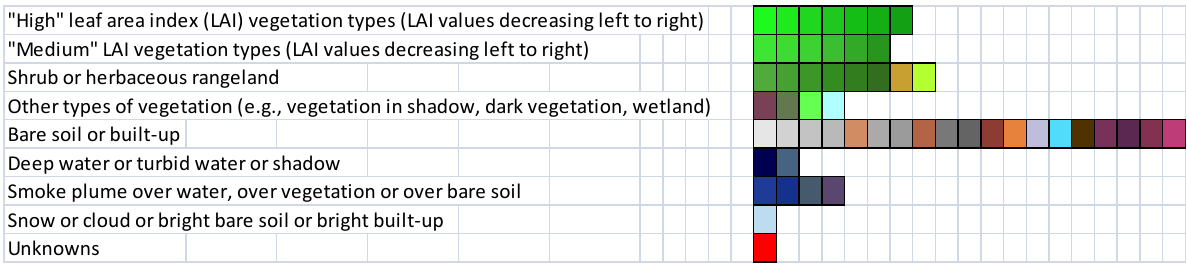
Table 3. Previously shown in [23]. Preliminary classification map legend adopted by Q-SIAM™ at fine semantic granularity consisting of 52 spectral categories (refer to Table 1). Pseudo-colors of the spectral categories are grouped on the basis of their spectral end member (e.g., ‘ bare soil or built-up ’) or parent spectral category (e.g., “high” leaf area index (LAI) vegetation types). The pseudo-color of a spectral category is chosen so as to mimic natural colors of pixels belonging to that spectral category. This legend gives a clue about the semantic “parent-child” relationship supported by Q-SIAM™ at different semantic granularity levels (refer to Figure 7 below). For example, a line-specific OR-combination of the 52 “child” spectral categories detected at the fine semantic granularity level across the 9 lines of Table 3 would provide 9 “parent” spectral categories at a coarser level of semantic granularity. Since it deals with symbolic reasoning, then this semantic aggregation is inherently subjective (equivocal, arbitrary, fuzzy) in nature, refer to Section 3 in [3].